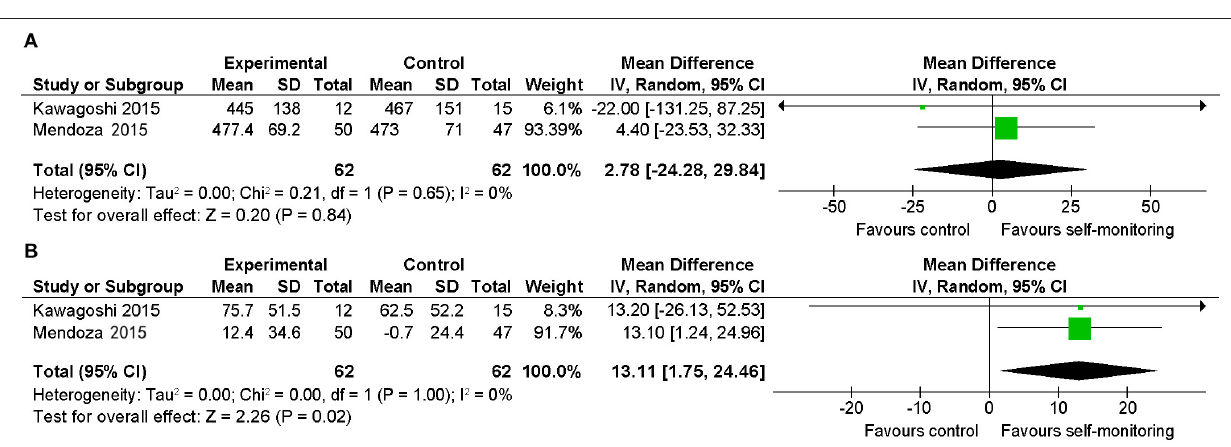
Hemophilia One RCT investigated the effect of self-monitoring in addition to a home-based exercise program in 37 patients with hemophilia (27). The final value of the timed 10-m